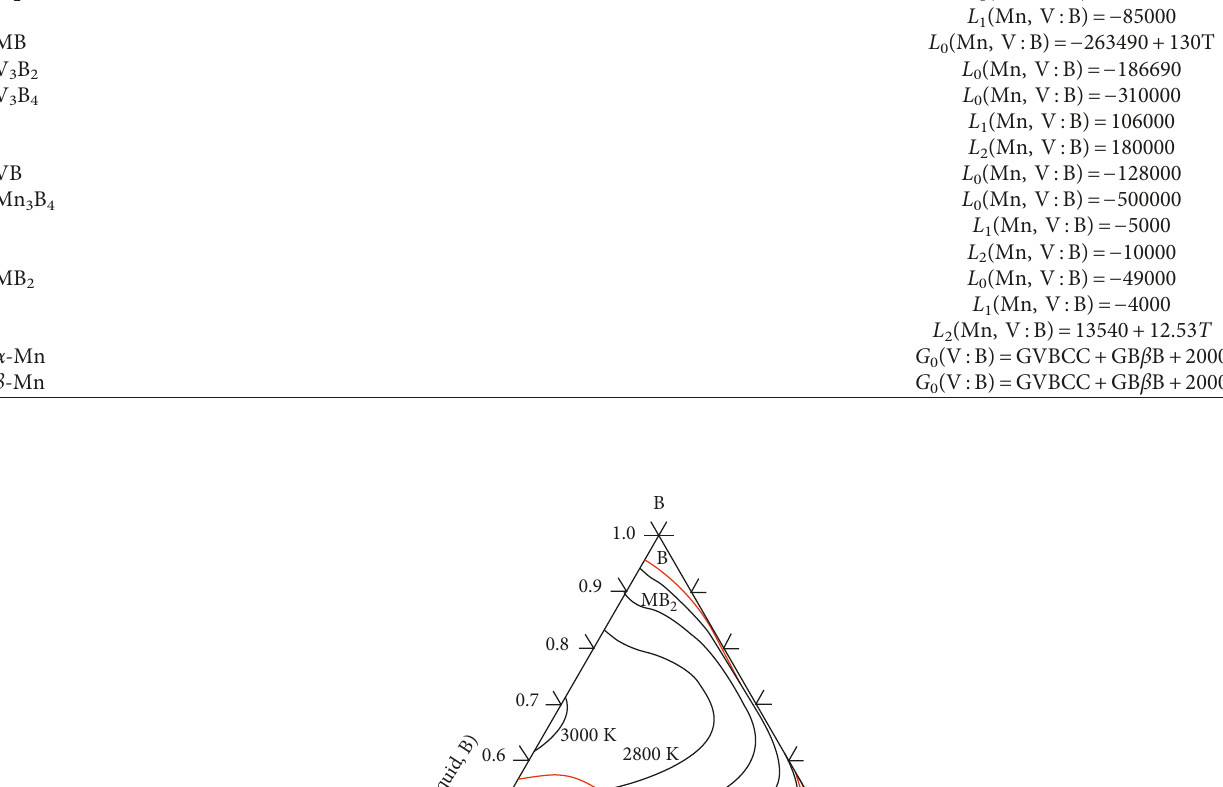
Table 4: Thermodynamic parameters for the B-Mn-V system developed in the present work.